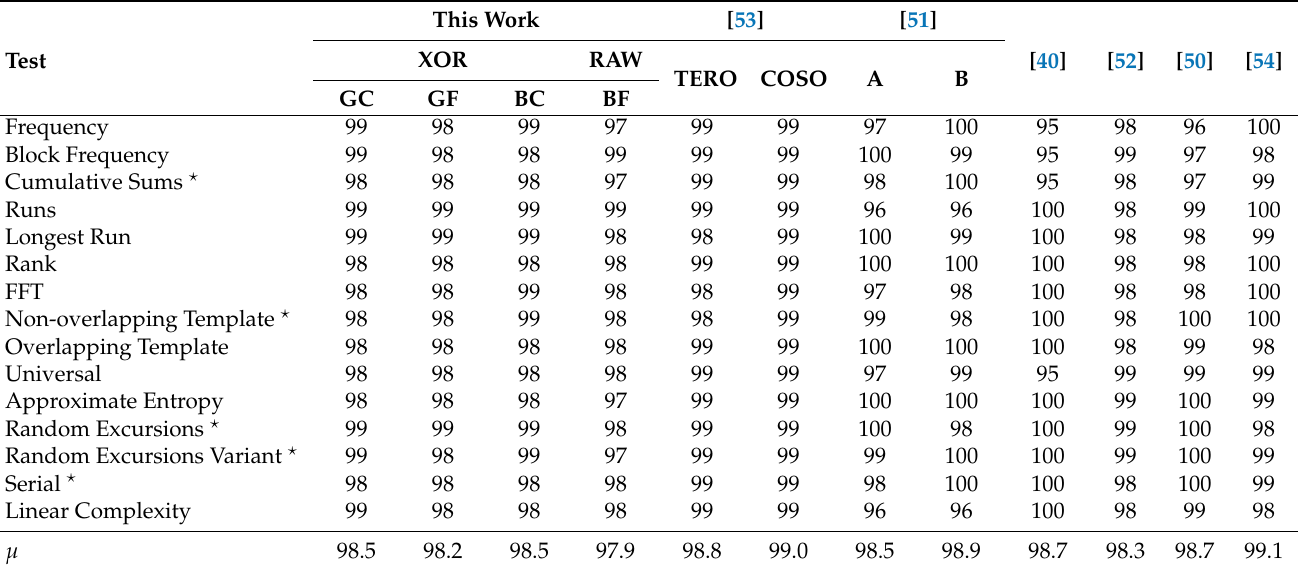
Table 6. Average test pass rate of the four TRNGs against those proposed in other related works using the NIST 800-22 statistical test